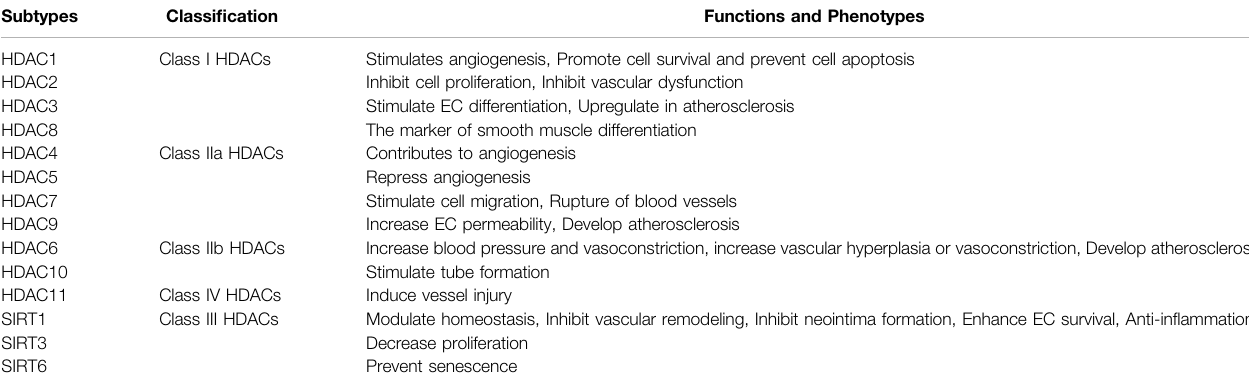
TABLE 1 | Roles of HDACs in blood vessels and the pathology of